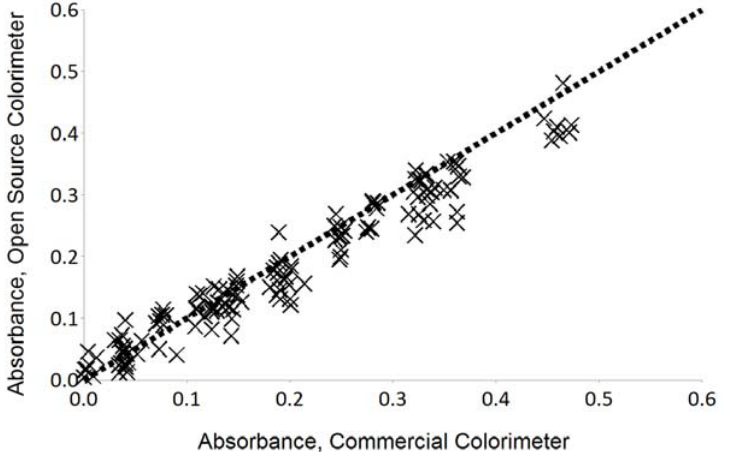
Figure 3. Comparison of the results from the commercial and open-source